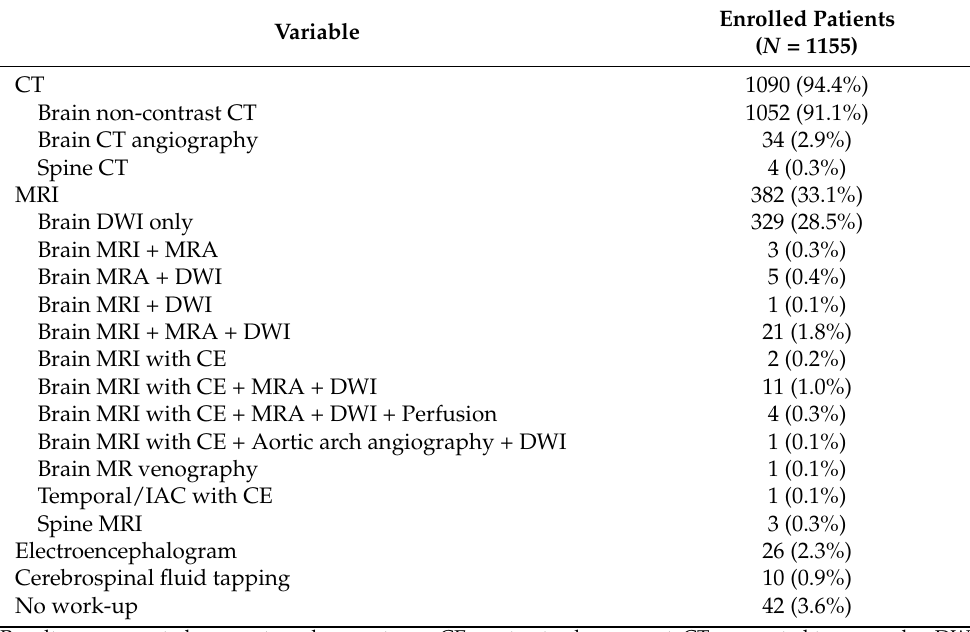
Table 2. The type of neurological diagnostic evaluation performed in the enrolled patients.